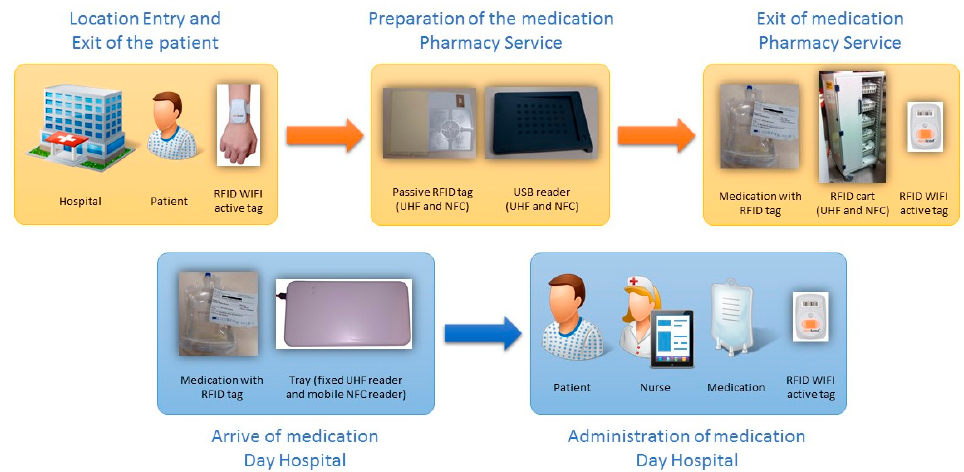
Figure 10. Infrastructure of the radio-frequency identification (RFID) systems.